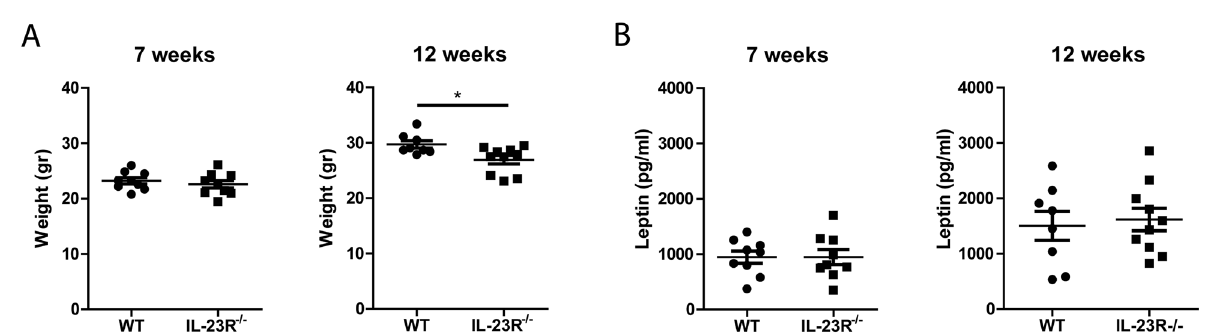
Figure 7. Serum leptin is similar to WT in 7- and 12-week-old IL-23R deficient mice. Seven- and 12-week- old WT and IL-23R −/− mice were weighed and serum was used for leptin measurement. ( A ) Weight of mice in grams. ( B ) Leptin measured in serum by ELISA. Pooled data of n = 9 mice (7 weeks) per group from two independent experiments, and n = 8–10 mice per group (12 weeks) from three independent experiments. Data are depicted as mean ± SEM. *p <